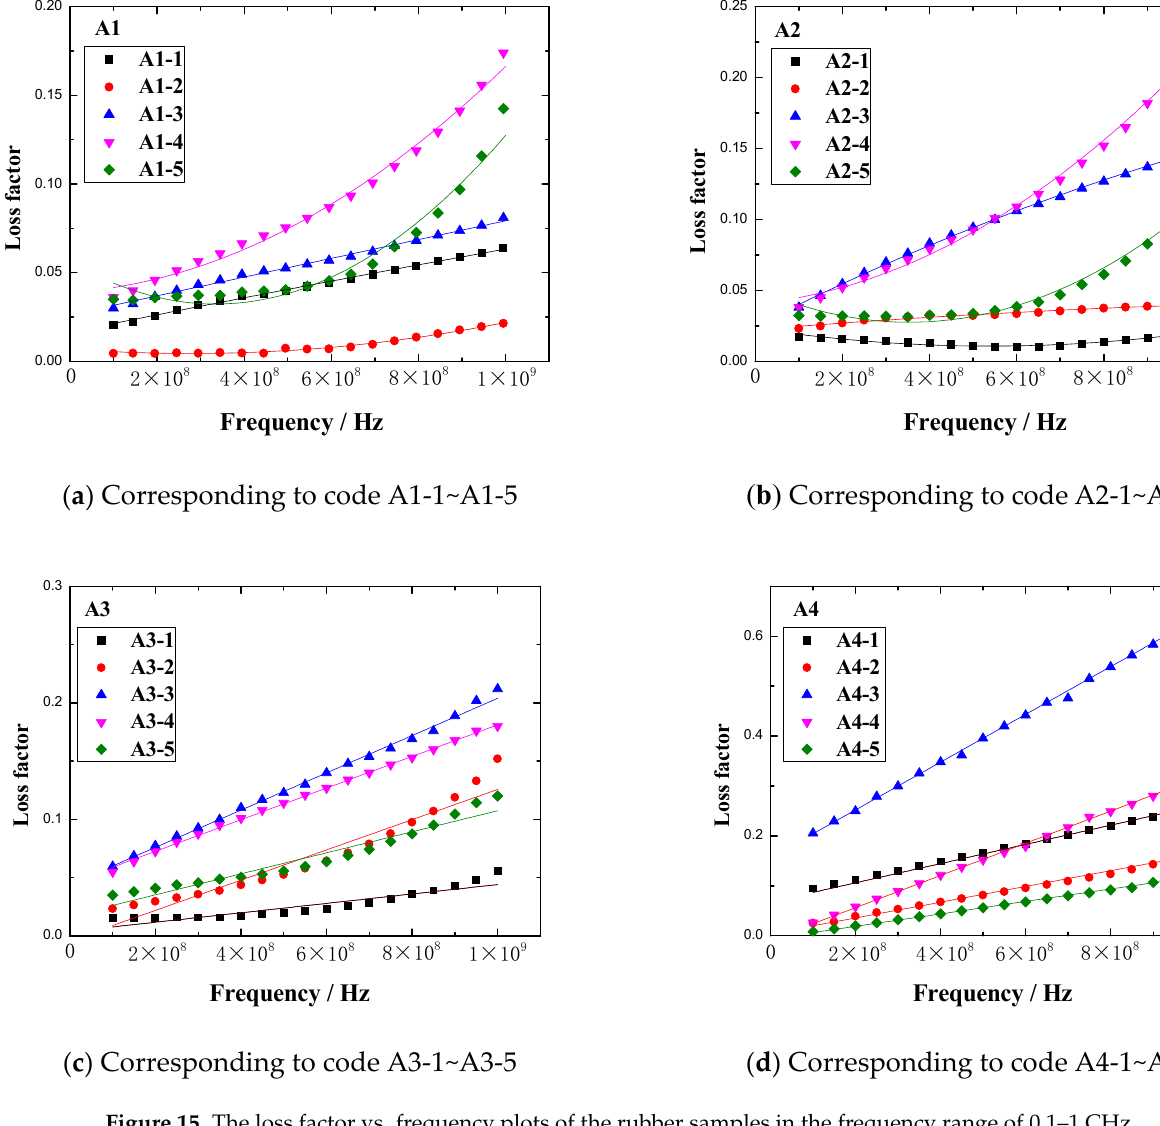
Figure 15. The loss factor vs. frequency plots of the rubber samples in the frequency range of 0.1–1 CHz.